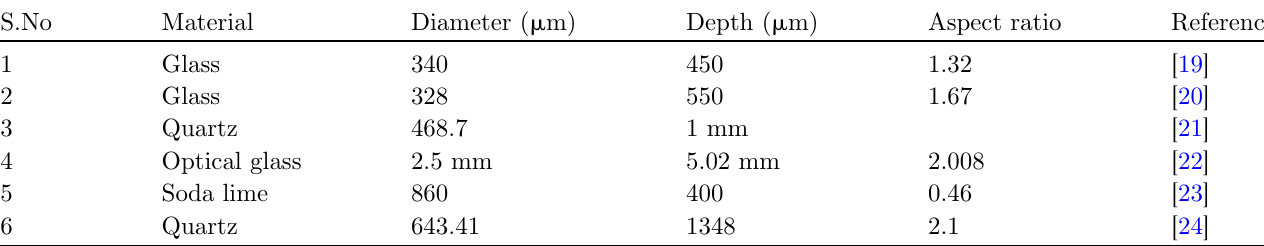
Table 1. Aspect ratio achieved by different researchers in ECDM